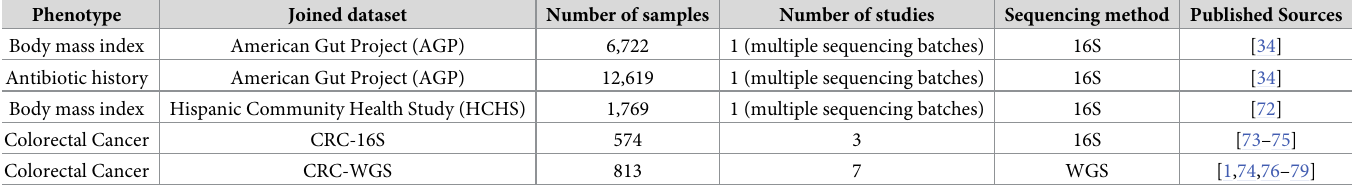
(Table 1). The datasets we analyzed included: (i) the American Gut Project [34] (AGP), which has known confounding variables [33], (ii) a pooled dataset composed of three 16S datasets with healthy and CRC individuals (hereafter referred to as ‘CRC-16S’) [27], (iii) a pooled data- set composed of seven whole metagenome sequenced datasets (WGS) with healthy and CRC individuals (hereafter referred to as ‘CRC-WGS’) [1,71], and (iv) the Hispanic Community Table 1. Datasets used in this study. Two pooled datasets composed of multiple studies are abbreviated as CRC-16S [73–75]and CRC-WGS [1,74,76–79], whereas the American Gut Project (AGP) [34] and the Hispanic Community Health Study (HCHS) [72] are each from a single source study and have several potential confounders